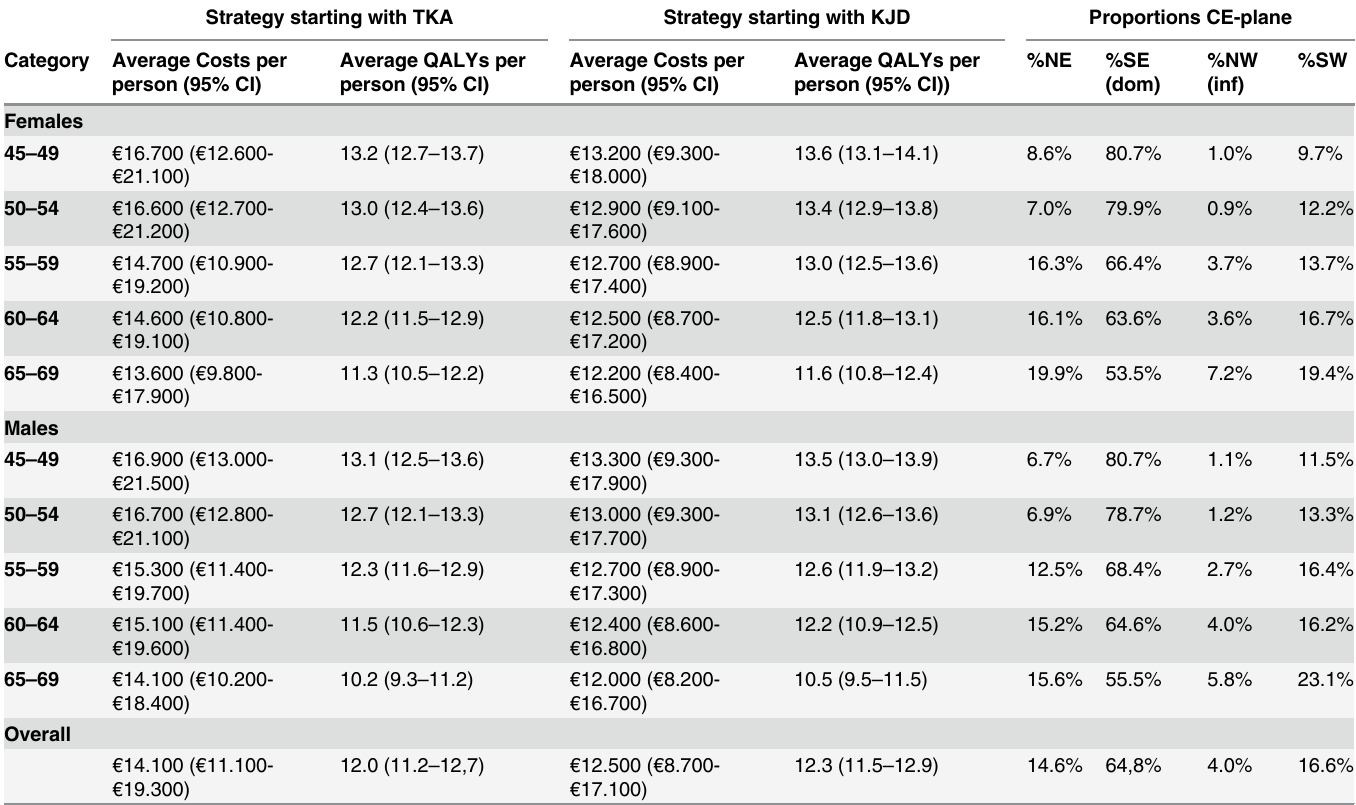
Table 4. Average costs per person, average QALY per person with 95% confidence limits, and the proportion of the results of the simulations per quadrant of the cost-effectiveness plane after 20-years Overall result: weighted average with weights according to the proportion of patients in the different gender and age categories undergoing TKA in the Netherlands [22]. Proportions CE-plane: The North-East (NE) quadrant indicates that the KJD strategy is more effective but also more costly than the TKA strategy. A result in the South East (SE) quadrant means that KJD is dominant. A result in the South West (SW) quadrant means that KJD is less costly but also less effective, and a result in the North West (NW) quadrant means that KJD is less effective and more costly